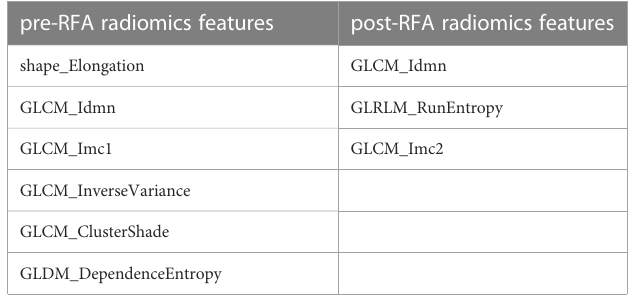
TABLE 3 Radiomics features selected by